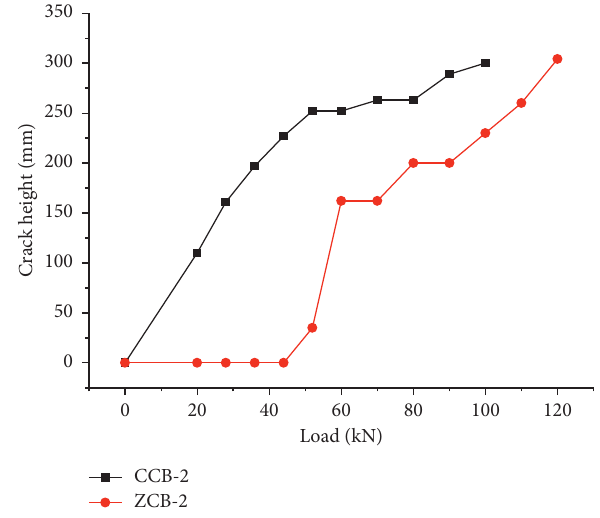
Figure 18: Development of crack height at the middle support.